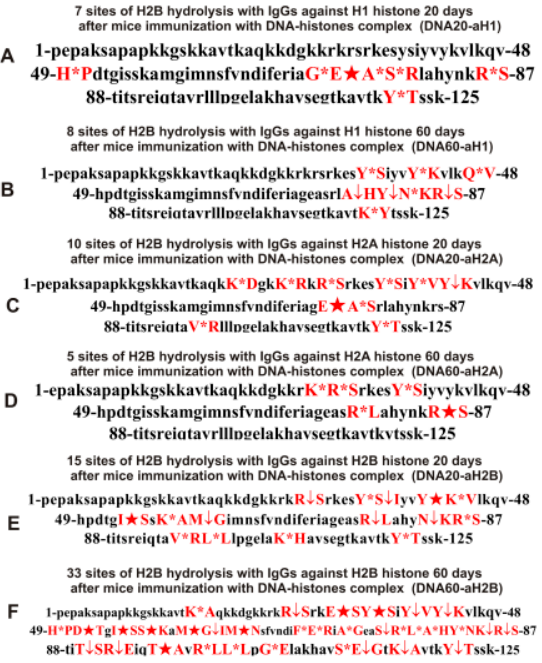
Figure 10. Sites of H2B hydrolysis by IgGs against three individual H1-H2B histones corresponding to 20 and 60 days after mouse immunization with DNA–histone complex: DNA20-aH1 ( A ), DNA60-aH1 ( B ), DNA20-aH2A ( C ), DNA60-aH2A ( D ), DNA20-aH2B ( E ), and DNA60-aH2B ( F ). Major sites of H2A cleavage are shown by stars ( ★ ), moderate sites by arrows ( ↓ ), and minor sites of cleavage by small stars (*).